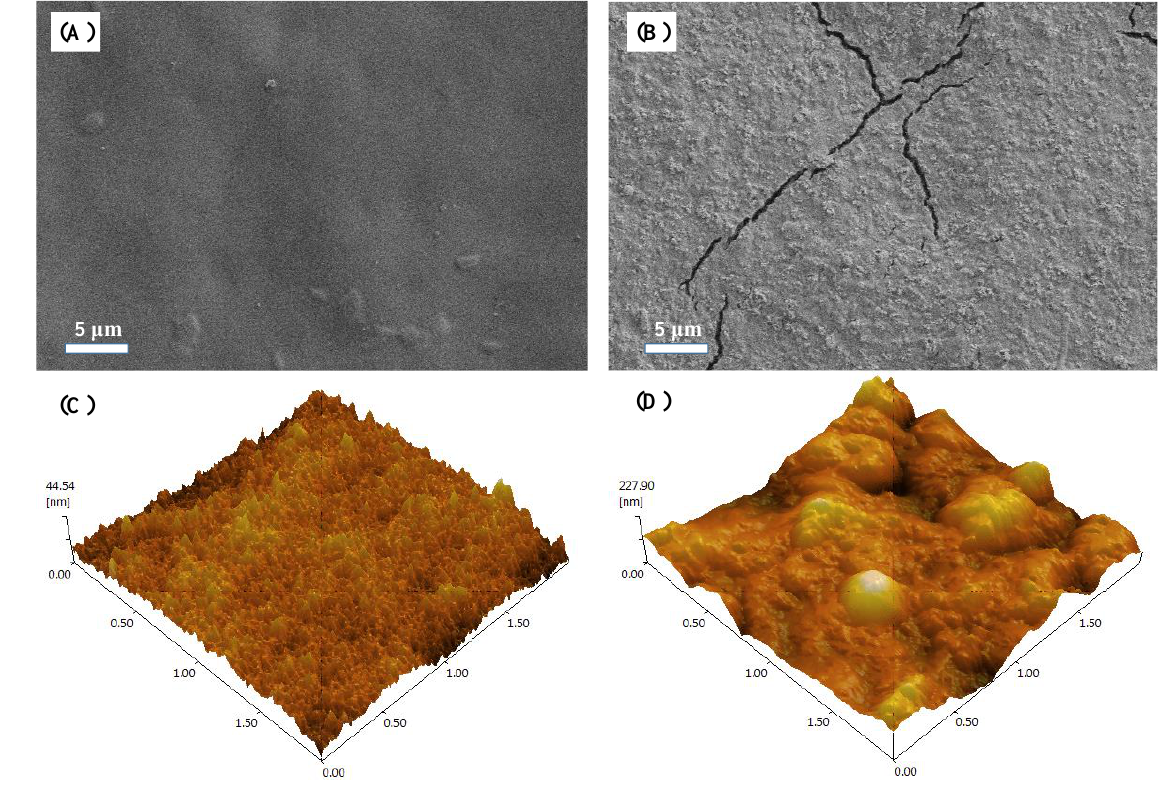
Figure 4. SEM and AFM measurements of the active layer of the pristine membrane ( A , C ) and fouled membrane ( B , D ) after concentrating biogas slurry. The fouled membrane is taken from 0.5 mol/L MgCl 2 as the drawing solution to process the fouled membrane after the membrane concentration is completed.